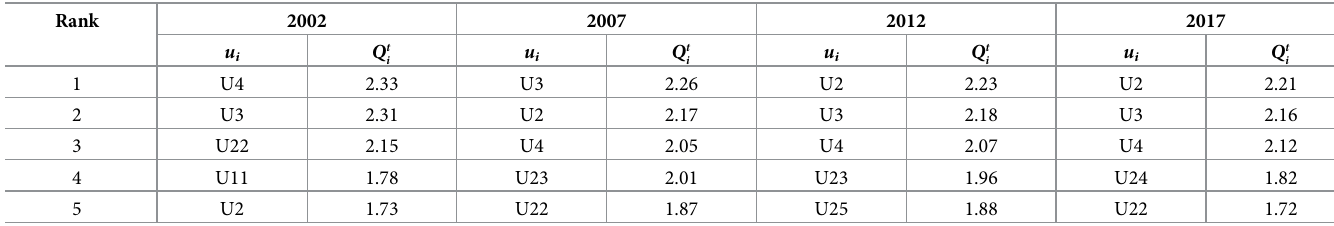
Table 6. Top 5 industries with induction coefficient.